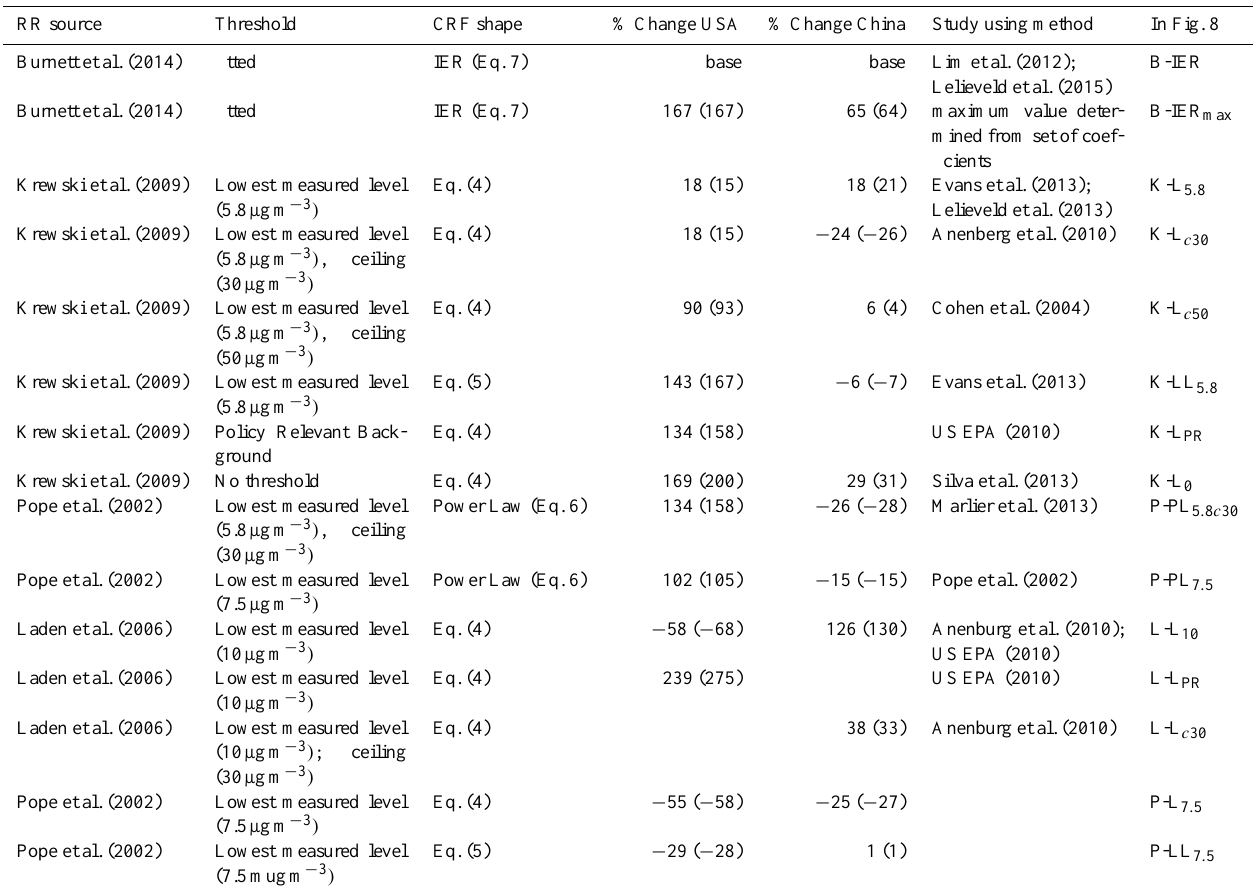
Table 3. Input for premature mortality burden estimate sensitivity tests and the resulting percent change in mortality due to chronic exposure determined from satellite-based concentrations. Parentheses are for values determined from model simulated